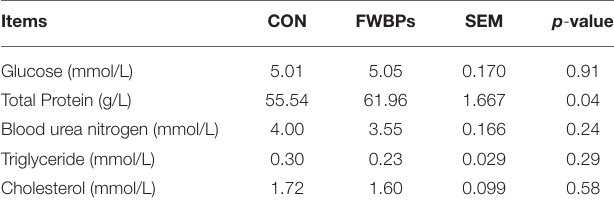
TABLE 5 | Effects of FWBPs on the ruminal morphology of early-weaned lambs.